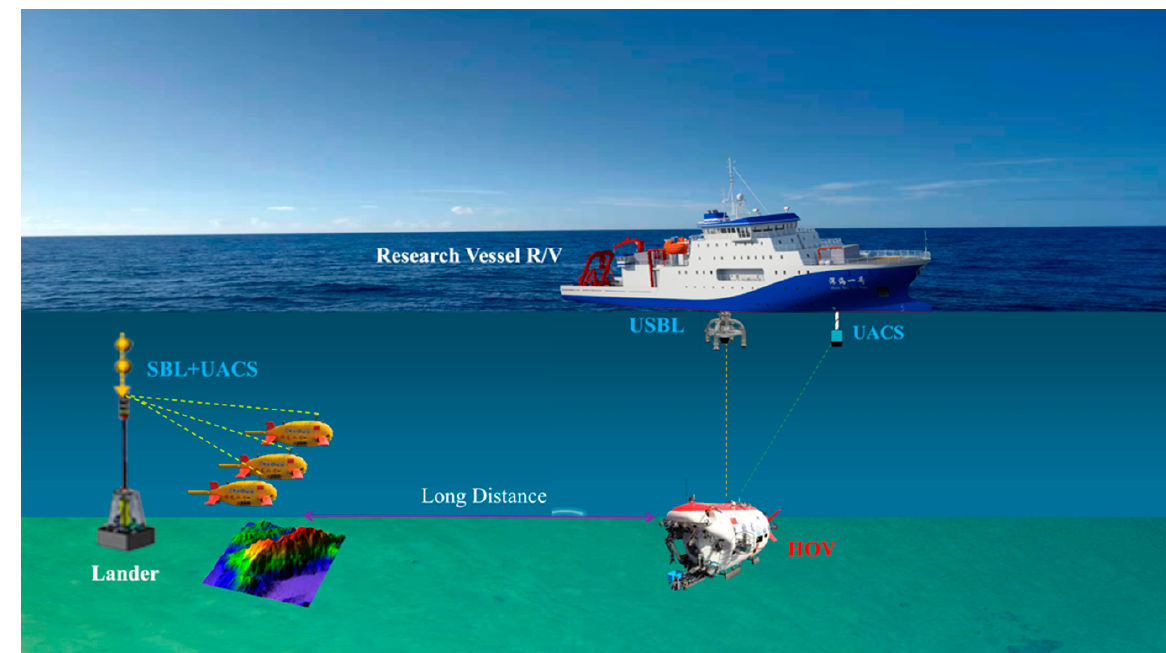
Figure 8. A scenario of cooperative operation based on a lander.